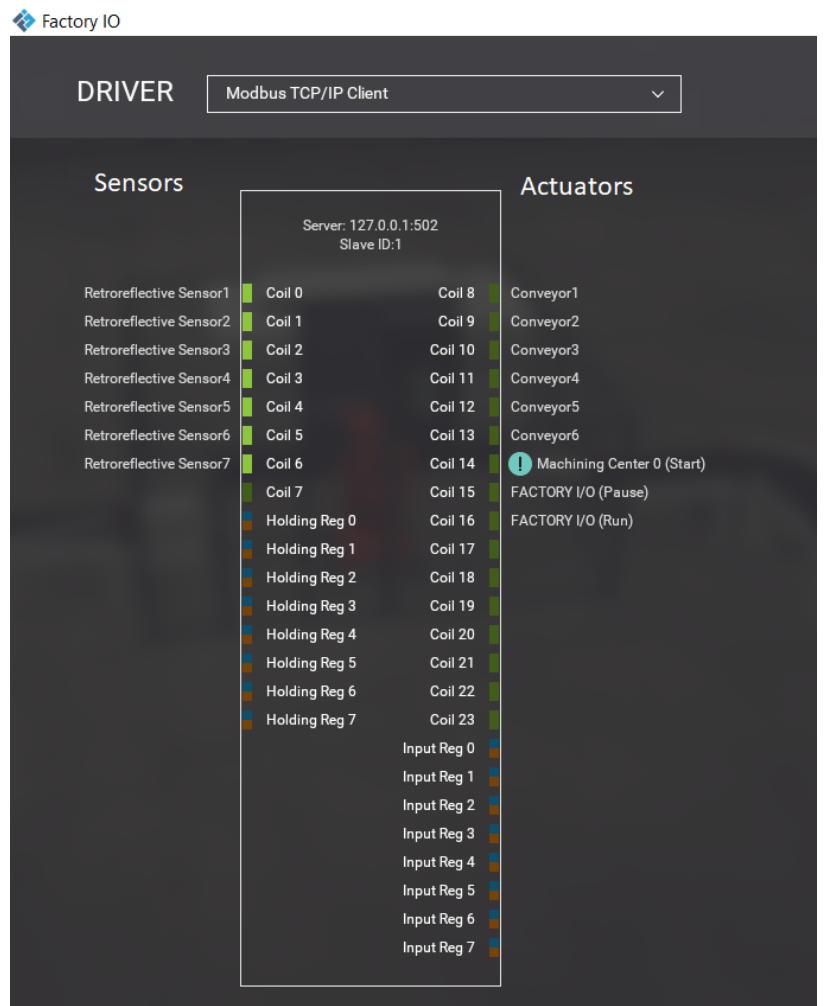
Figure 10. Factory I/O—Modbus